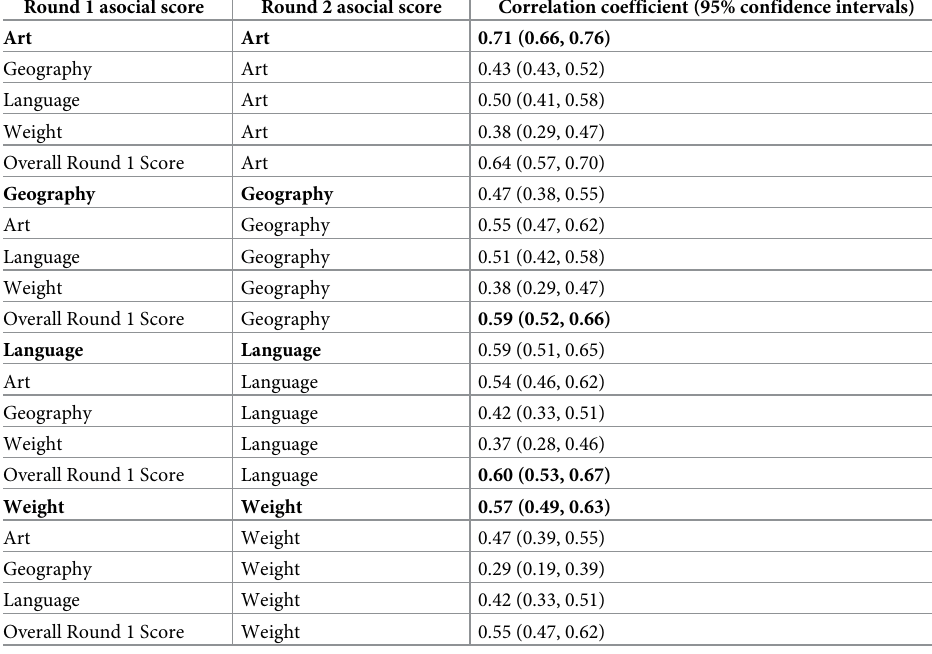
Table 2. Correlation coefficients between Round 1 and Round 2 topic scores representing total variance of Round 2 topic score explained by Round 1 score of the same topic.